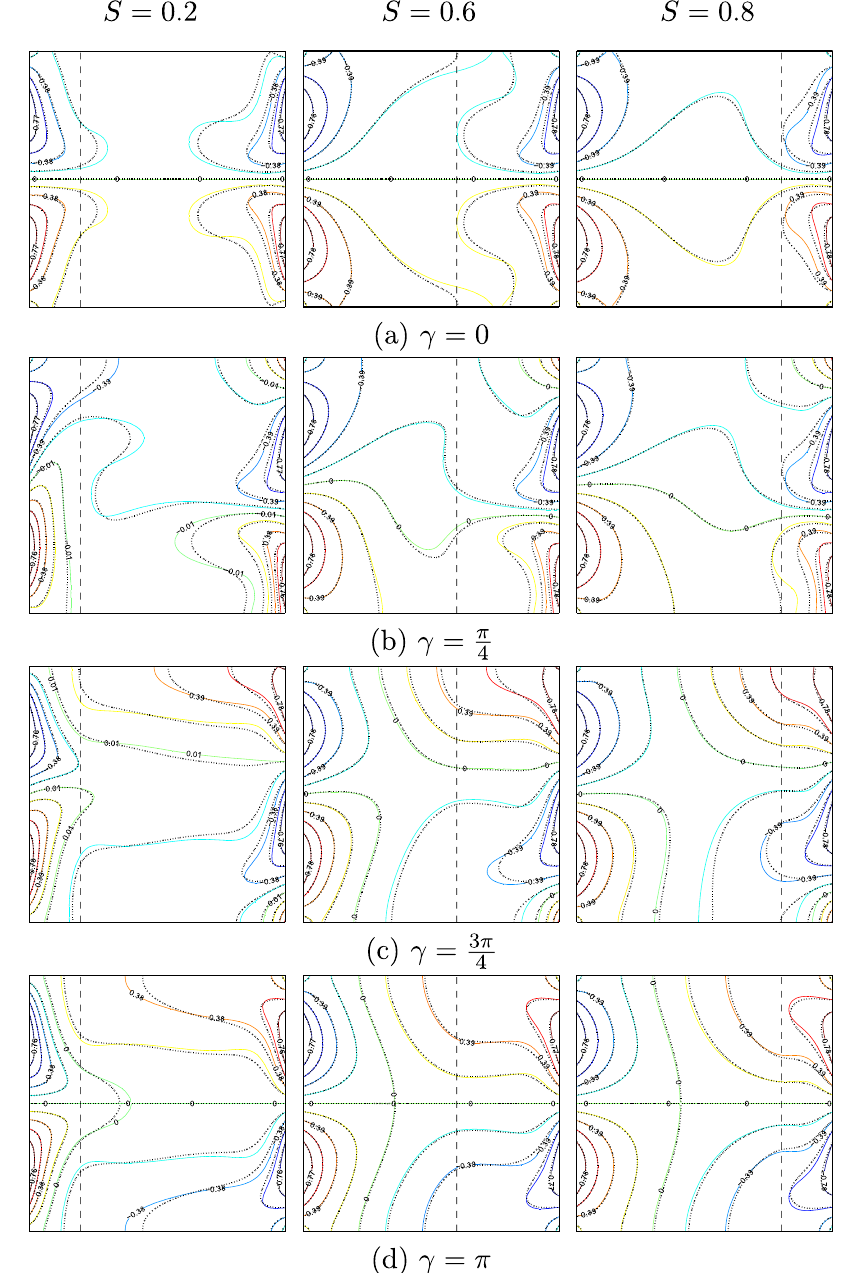
Figure 5. Isotherms evolution by γ and S for Ra bf = 10 5 , Da = 10 − 4 , ε = 1, ϕ = 0°, φ = 0 (solid lines) and φ = 0.1 (dashed